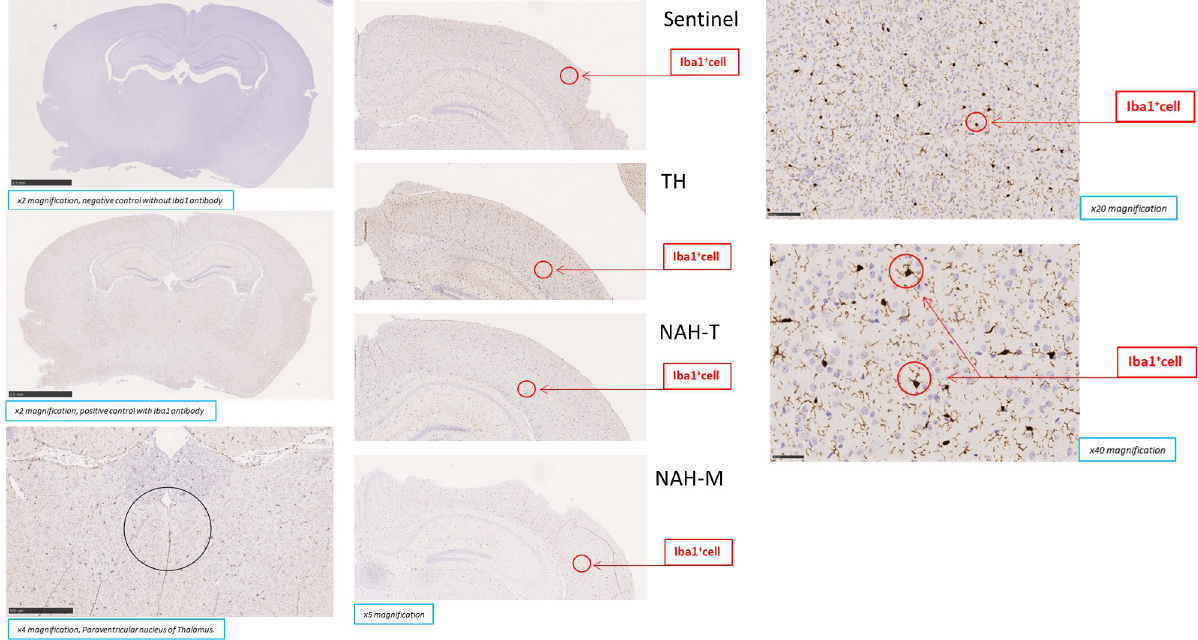
Fig 5. Activated microglia in the brain. Histological analysis of the brain. Presence of activated microglia was found (Iba1+ cells in the red circle), but there was not significant difference between R&L stressed mice, regardless of handling, and Sentinels, suggesting that if an inflammatory process occurred in BM, it did not reach the central nervous system. Left: above a x2 magnification of negative control without Iba1 antibody, in the middle a x2 magnification of positive control with Iba1 antibody, below a 4x magnification of PVN (area inside the circle, see methods for stereotaxic coordinates). Center: a representative photomicrograph for each handling group (x5 magnification). Right: a series of images with different degrees of magnification of Iba1+ cells (x20 and x40).